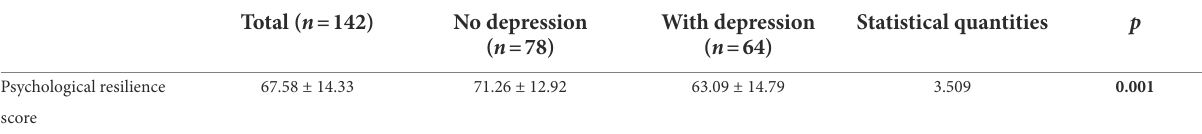
TABLE 9E Analysis of influencing factors of